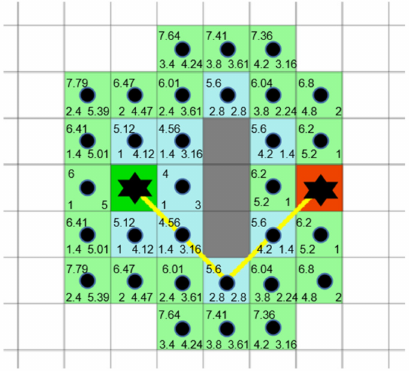
Figure 2. Schematic diagram of A* algorithm path planning based on Euclidean